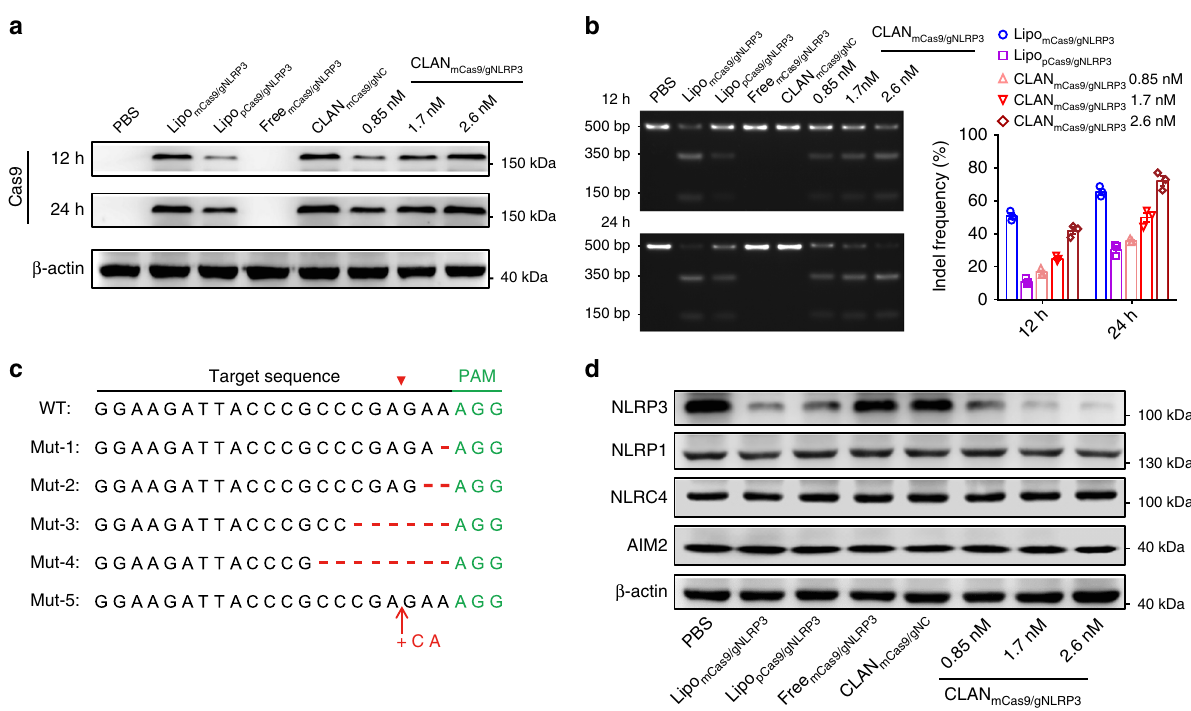
Fig. 2 Detection of Cas9 expression and NLRP3 knockout ef fi ciency in BMDMs transfected with CLAN mCas9/gNLRP3 in vitro. a , b Immunoblot analysis of Cas9 protein expression ( a ) or T7E1 assay of indels introduced into the NLRP3 locus ( b ) in BMDMs transfected with different formulations at 12 or 24 h post-transfection. c Representative sequences of indels in the NLRP3 locus of BMDMs transfected with CLAN mCas9/gNLRP3 . See also Supplementary Fig. 8. WT, wild type, Mut, mutation. The PAM motif is in green, and the inserted bases are in red. d Immunoblot analysis of the NLRP3 knockout ef fi ciency and other in fl ammasome protein expression in BMDMs transfected with different formulations at 72 h post-transfection. The data are representative of three independent experiments ( a , d ) or are shown as the means± SEM of n = 3 ( b in peritoneal macrophages at 12 or 24 h after CLAN mCas9/gNLRP3 injection (Fig. 4a). Next, we measured the NLRP3 knockout ef fi - ciency of CLAN mCas9/gNLRP3 by detecting indels in the targeting locus of peritoneal macrophages using the T7E1 assay. The data showed that the indel frequency was dose-dependent and time- dependent, and reached 47.1% at 24 h after CLAN mCas9/gNLRP3 (2 mg kg − 1 ) injection (Fig. 4b). The representative sequences of indels in the NLRP3 locus of peritoneal macrophages from mice injected with CLAN mCas9/gNLRP3 (2 mg kg − 1 ) are displayed in Fig. 4c and Supplementary Fig. 10. Expression of the NLRP3 protein in peritoneal macrophages was also analyzed and showed that NLRP3 expression was dose-dependently inhibited by CLAN mCas9/gNLRP3 , while other in fl ammasome proteins, including NLRP1, NLRC4 and AIM2, were not affected (Fig. 4d). The expression of NLRP3 in CLAN mCas9/gNLRP3 groups at the doses of 0.5, 1, and 2 mg kg − 1 was 81.5, 64.3, and 56.8% of that in PBS group, respectively (Fig. 4d). Considering that mice were only injected with CLAN mCas9/gNLRP3 for a single injection, the knockout ef fi ciency was acceptable. Because off-target effects are a large concern for the clinical application of CRISPR/Cas9 57 , we isolated the genome of peritoneal macrophages at 72 h after CLAN mCas9/gNLRP3 (2 mg kg − 1 ) injection and detected the indel frequency in potential off-target sites of NLRP3 gRNA. As shown in Supplementary Fig. 11, the indel frequency in six potential off- target sites was lower than 0.5%, while the indel frequency in the NLRP3 locus was 58.6%. These results indicated that CLAN mCas9/ gNLRP3 could disrupt the NLRP3 gene of macrophages in vivo with a low off-target effect. CLAN mCas9/gNLRP3 mitigates LPS-induced septic shock . We have demonstrated that CLAN mCas9/gNLRP3 can inhibit NLRP3